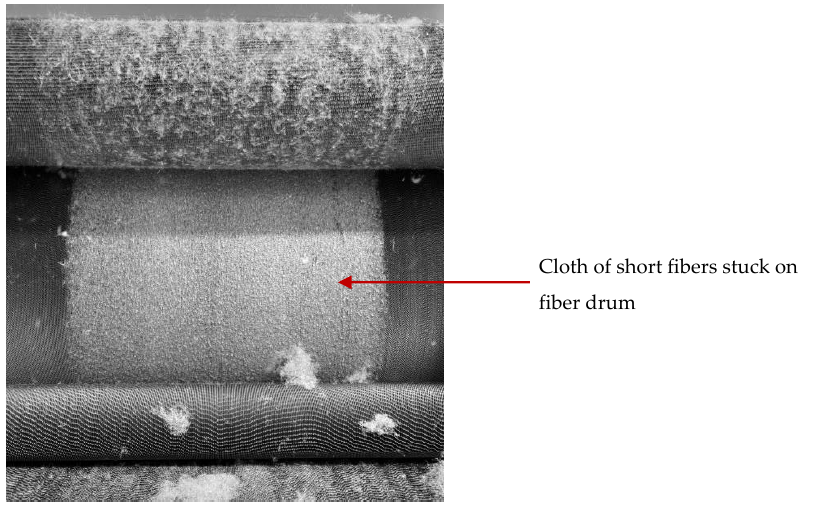
Figure 2. Recycled denim fibers stuck between the needles on the drum in the carding